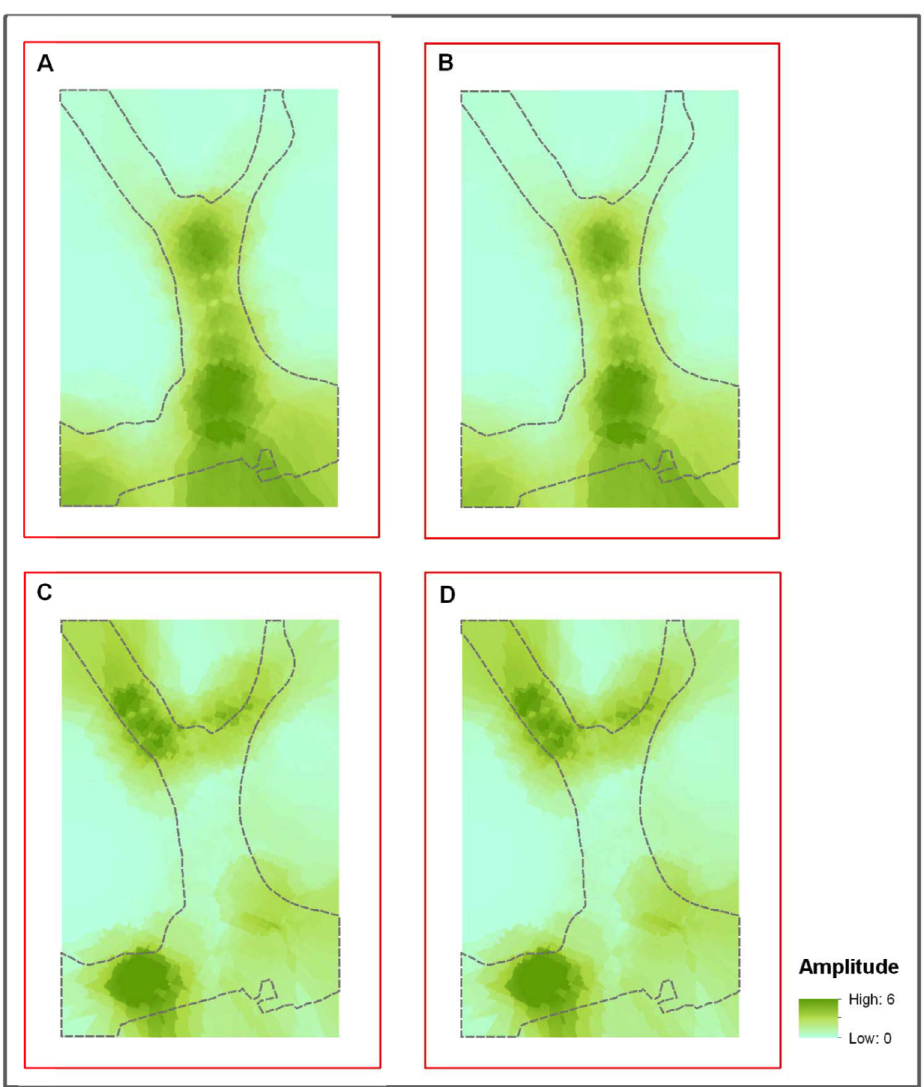
Figure 15. Spectral amplitude at 1 Hz (top) and 2.5 Hz (bottom) for a near-field seismic motion (left) and a far-field seismic motion